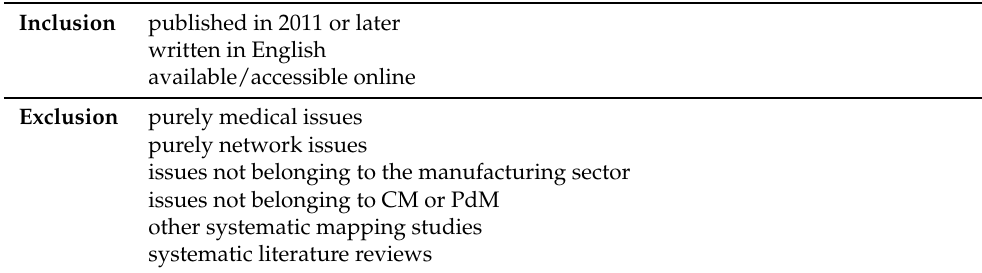
Table 2. Inclusion and exclusion